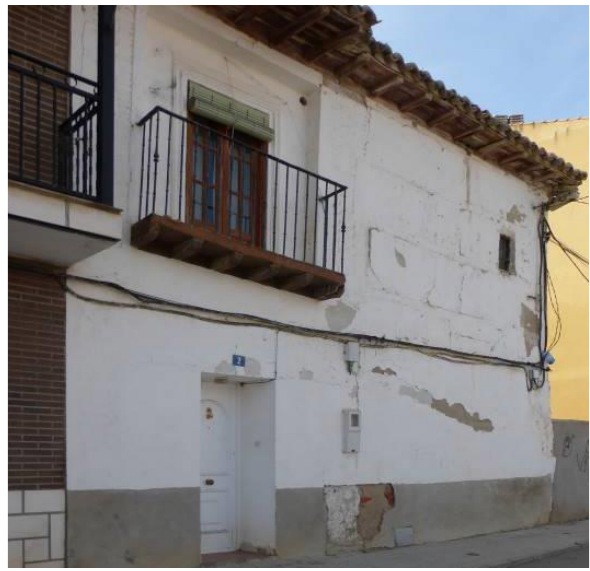
Figure 7. House in Magan where its traditional window is kept while the main door has been